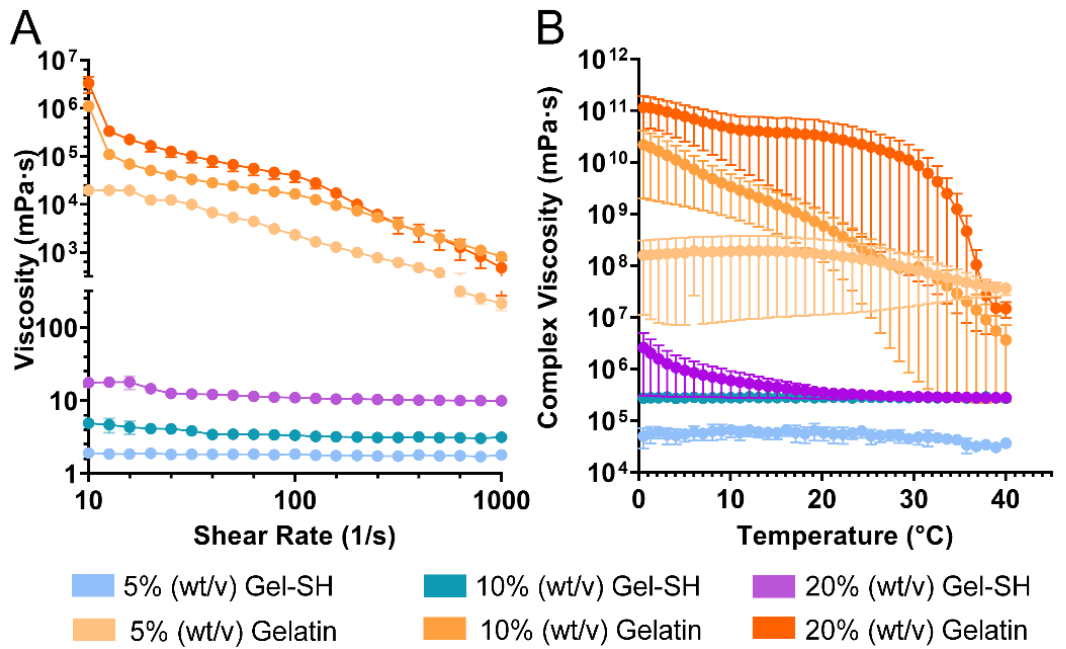
Figure 2. Flow properties of Gel-SH. ( A ) Shear-rate sweeps of Gel-SH and porcine gelatin were conducted at room temperature (25 °C) using a 25 mm cone plate, with shear-rate range of 0.1–1000 /s, at a constant frequency of 1 Hz (mean ± SEM; n = 3); ( B ) Temperature sweeps of Gel-SH and porcine gelatin conducted using a 25 mm parallel plate at a constant frequency of 1 Hz, and constant strain of 1%, with temperature ramping linearly from 37 °C, at a rate of 2 °C/min (mean ± SEM; n = 3).